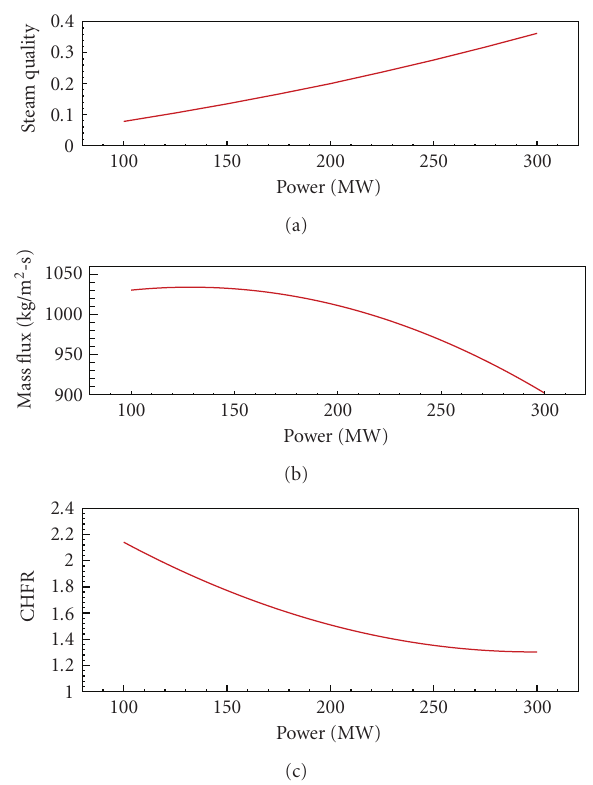
Figure 10: The variations of (a) steam quality, (b) mass flux, and (c) CHFR with